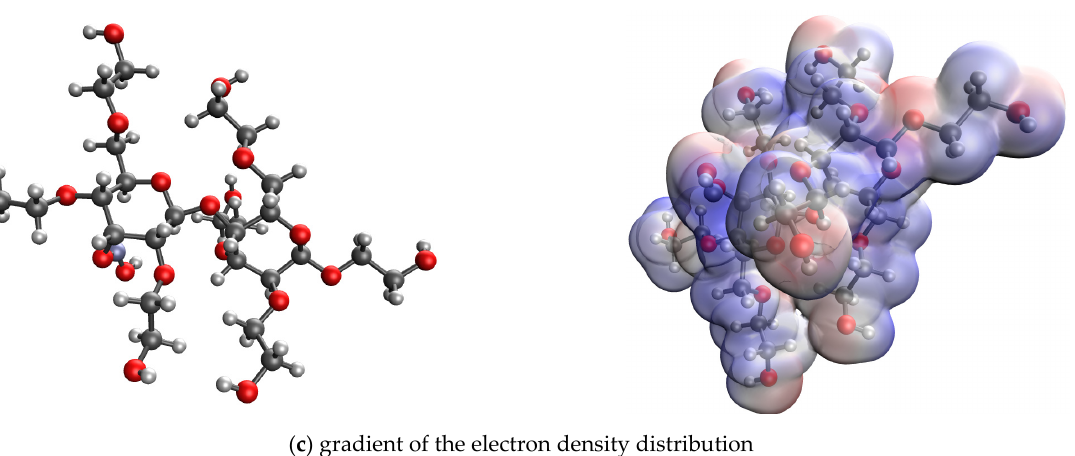
Table 2. Results of quantum chemical modeling.